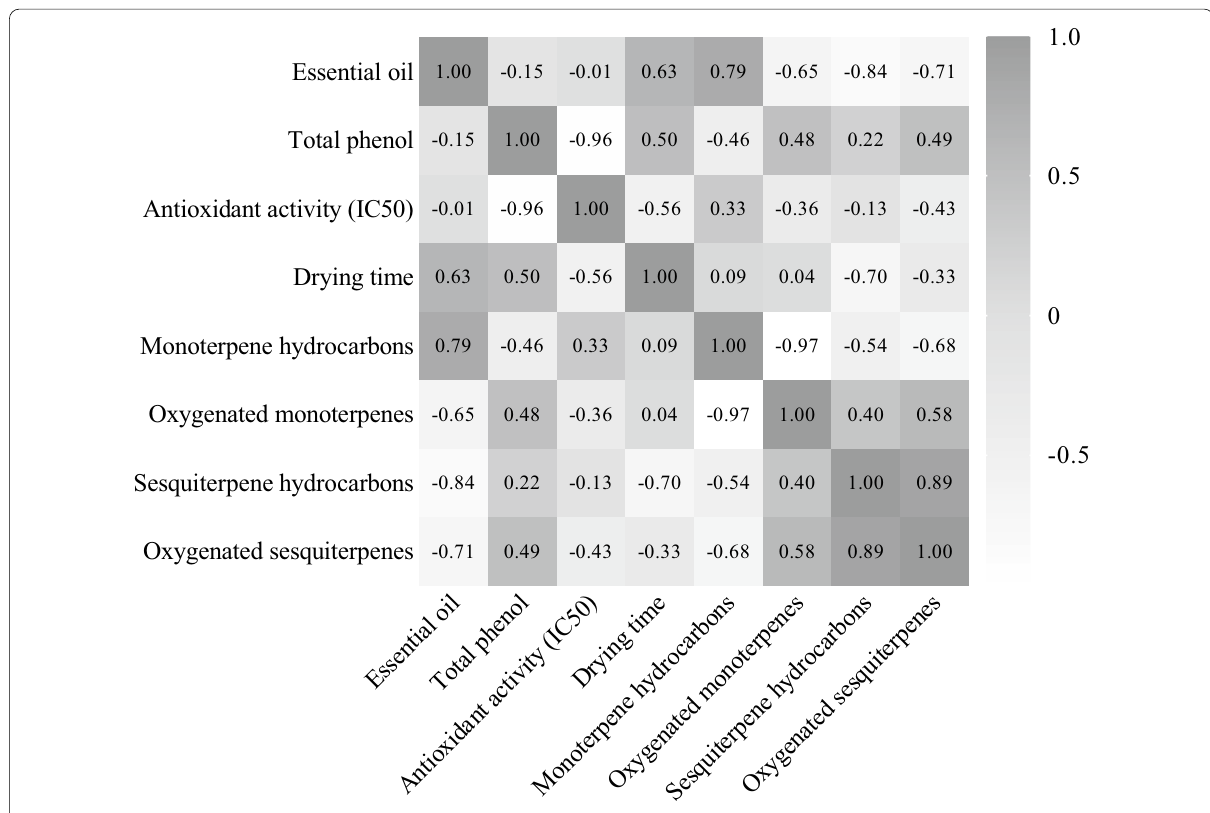
Fig. 2 Heat map obtained for correlation between evaluated traits